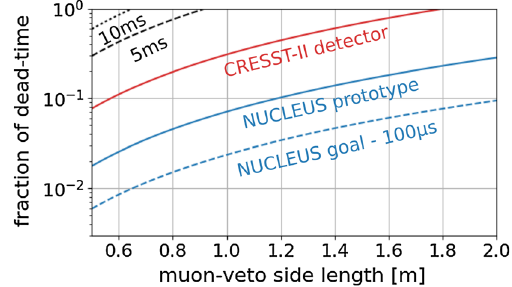
Fig. 10 Detector dead time vs. dimension of the cubic-shaped muon veto. The lines indicate the predicted values for the NUCLEUS pro- totype detector (300 µ s rise time, blue line) and a CRESST-II detec- tor (1.3ms rise time, red line) based on TES technology. The relation between rise time and timing uncertainty is taken from a neutron beam coincidence measurement (see text). For comparison, expected dead times of slower detectors with 5ms rise time (black dashed line) and 10ms rise time (black dotted line), as well as a NUCLEUS detector with an envisioned rise time of 100 µ s (blue dashed line) are